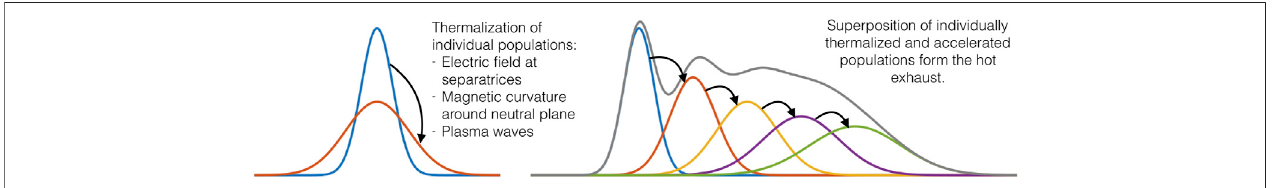
FIGURE 10 | Illustration of thermalization process of cold ions. Individual populations are thermalized by one or several processes, for example separatrix activity, magnetic fi eld curvature scattering, or plasma waves. The hot exhaust is formed by a superposition of these individually thermalized populations that are accelerated to different